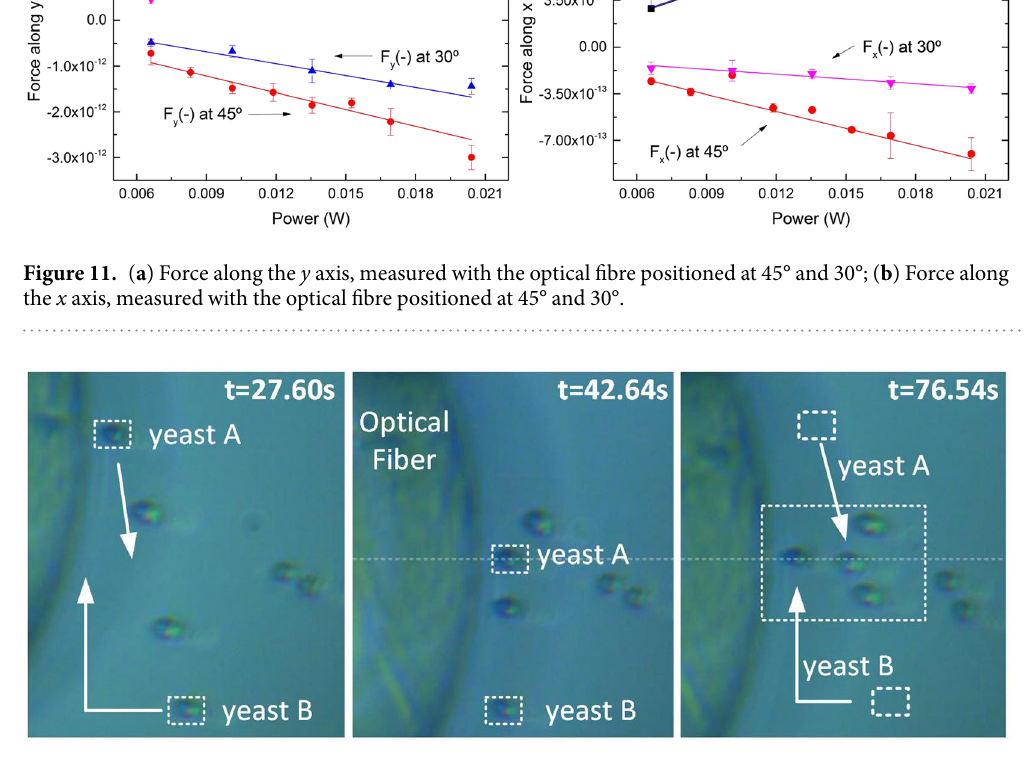
Figure 12. Rearrangement/sorting of two yeast cells, A and B, to a specific location (see Supplementary Video